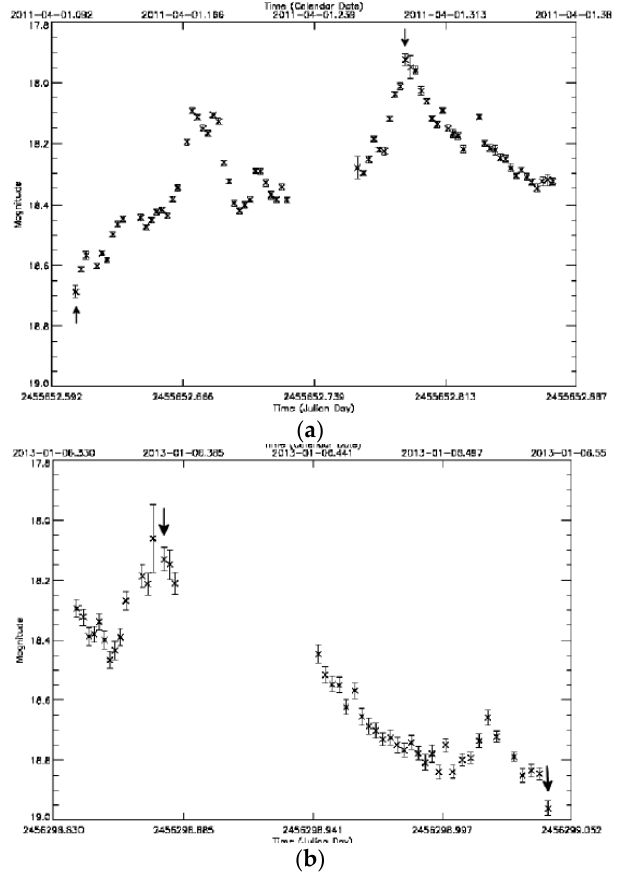
Figure 2. (a) Intra-night light curve of J0948+0022. The light curve share a ~1.0 magnitude range. The object is in an excited state showing a flux doubling time of 4.39 ± 0.19 hours. The arrows indicate the extreme range during this observation. All data was obtained in the optical R band; (b) Intra-night light curve of J0948+0022. The light curve shows a ~0.8 magnitude range. The object is in an excited state showing a flux doubling time of 3.60 ± 0.23 hours. The arrows indicate the extremes. A low amplitude ~0.10 mag event with a duration of a 1.4-hours is centered near ~2456299.01 JD. All data was obtained in the optical R band.